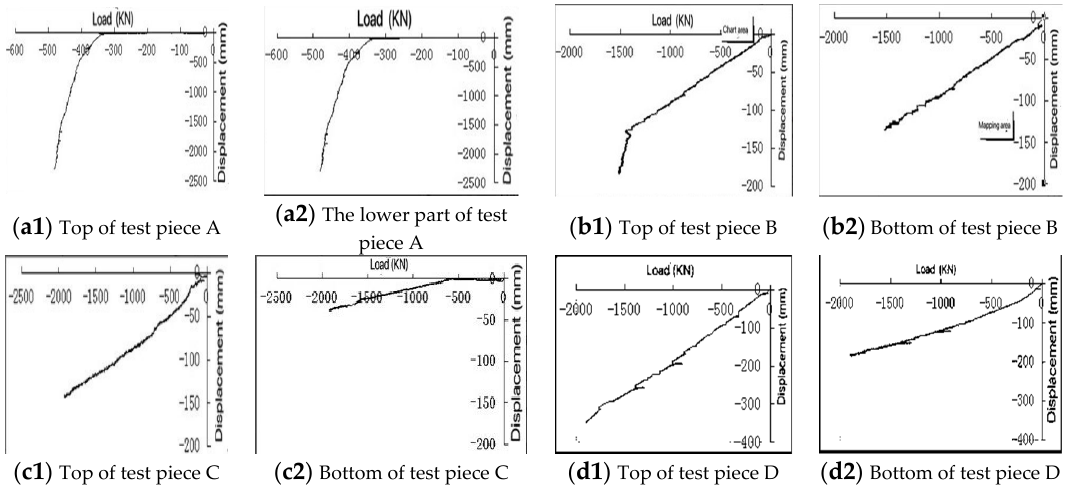
Figure 3. Loading process.